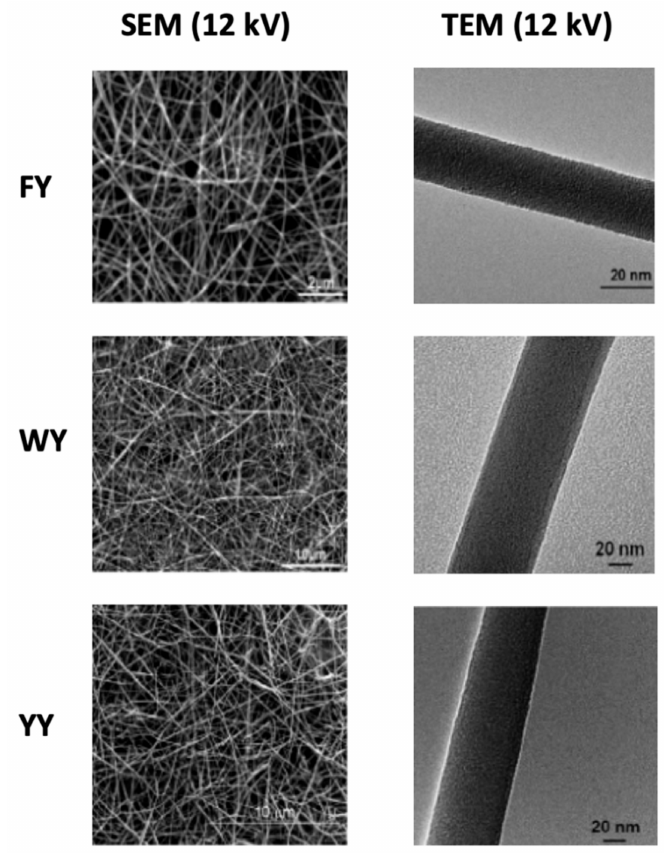
Figure 4. Scanning and transmission electron micrographs SEM and TEM micrographs of Phe-Tyr (FY), Trp-Tyr (WY) and Tyr-Tyr (YY). Reproduced from [25] with permission from The Royal Society of